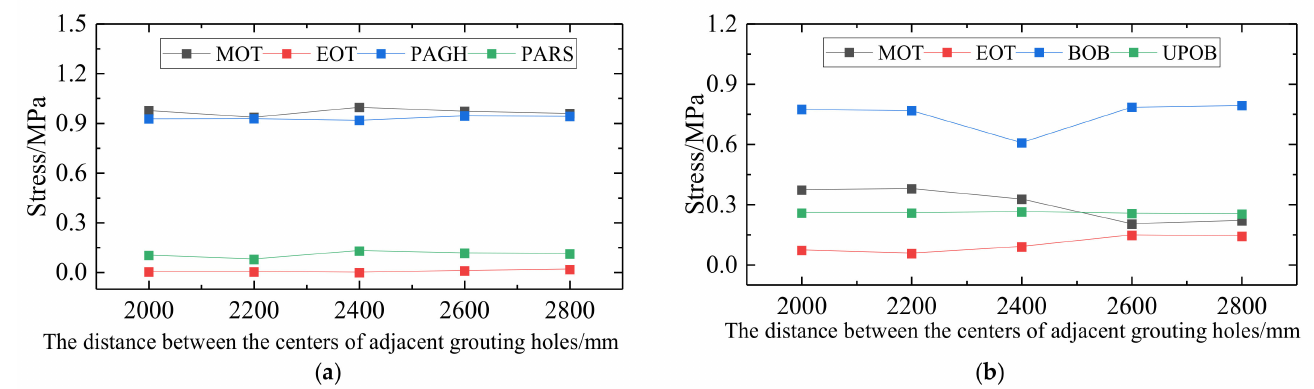
Figure 23. Stress variation curve of track structure under different distance between the centers of adjacent grouting holes conditions: ( a ) Track slab; ( b ) Adjustment layer.